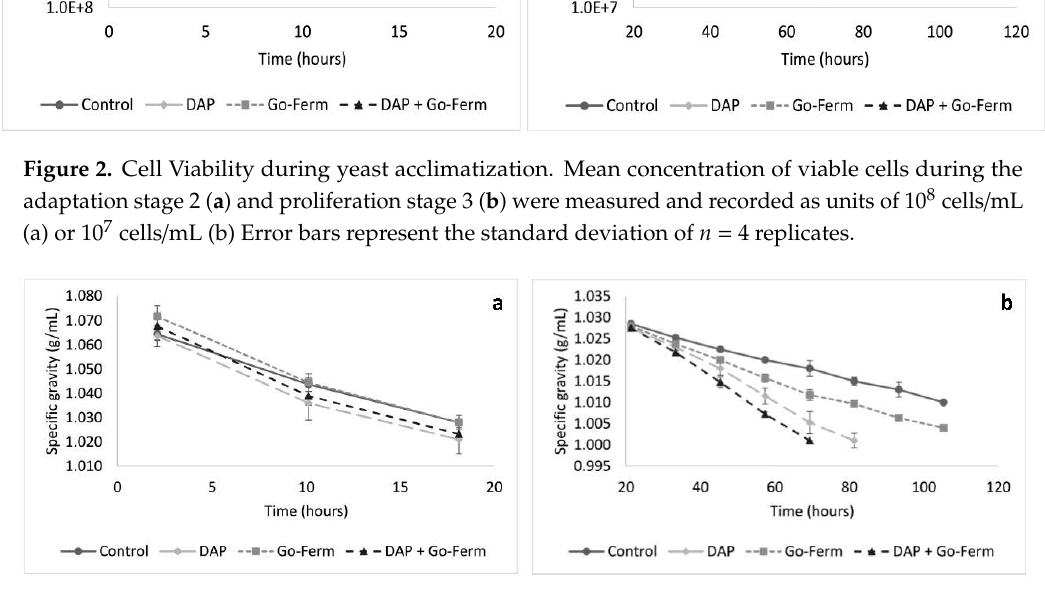
Figure 3. Sugar consumption during yeast acclimatization. Mean sugar consumption throughout yeast acclimatization represented as a decrease in specific gravity during the adaptation stage 2 ( a ) and proliferation stage 3 ( b ). Error bars represent the standard deviation of n = 4 replicates. Table 3. Rate of sugar consumption during yeast acclimatization calculated from the difference in time and specific gravity at the start and end of adaptation stage 2 and proliferation stage 3, respectively. Treatments were replicated ( n = 4) and are represented as the mean ± standard deviation. Lower case letters indicate statistical differences in sugar consumption rates between treatments determined by ANOVA with mean separation by Fisher’s Protected (LSD0.05). Rate of Sugar Consumption (mg/mL/hour) Adaptation Stage 2